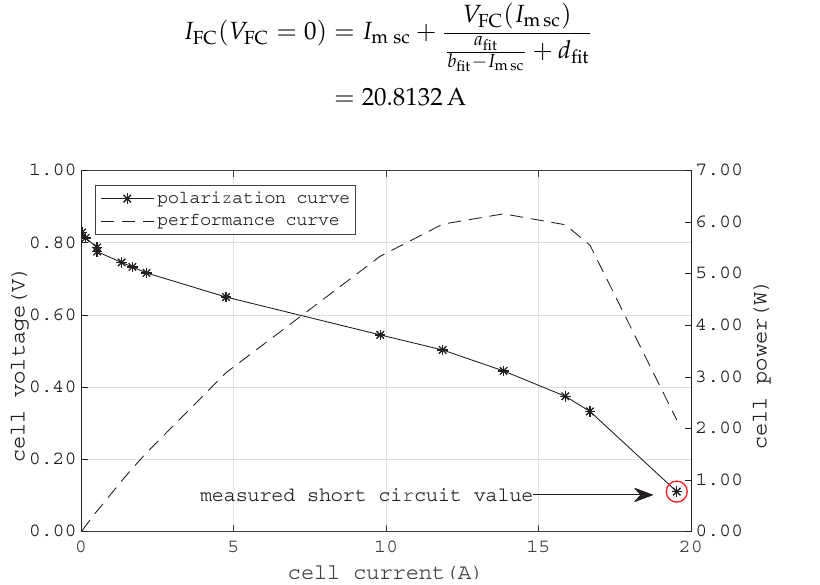
Figure 8. Measured polarization and performance curves of the tested fuel cell. The added value for the stationary short circuit current is marked by a red circle.